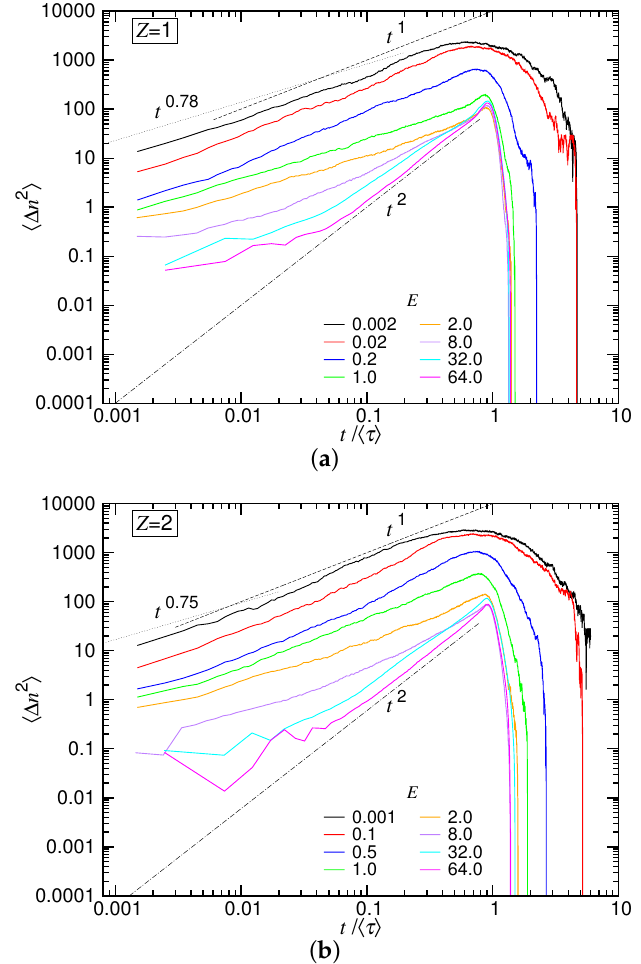
Figure 14. Variance of the translocation coordinate, (cid:104) ∆ n 2 (cid:105) , versus the normalized time, t / (cid:104) τ (cid:105) in ( a ) the monovalent salt solution and ( b ) the divalent salt solutions. The chain has N = 123. The strength of the driving field is indicated in the